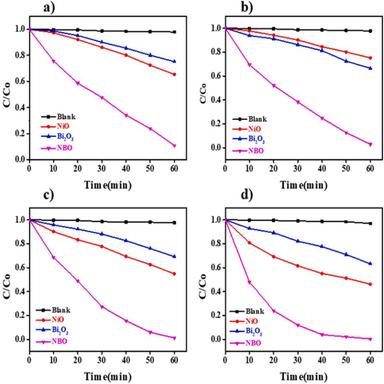
Photodegradation of MO dye a) 20 ppm, b) 15 ppm, c) 10 ppm, d) 5 ppm blank and presence of pure NiO, Bi2O3 and NBO.